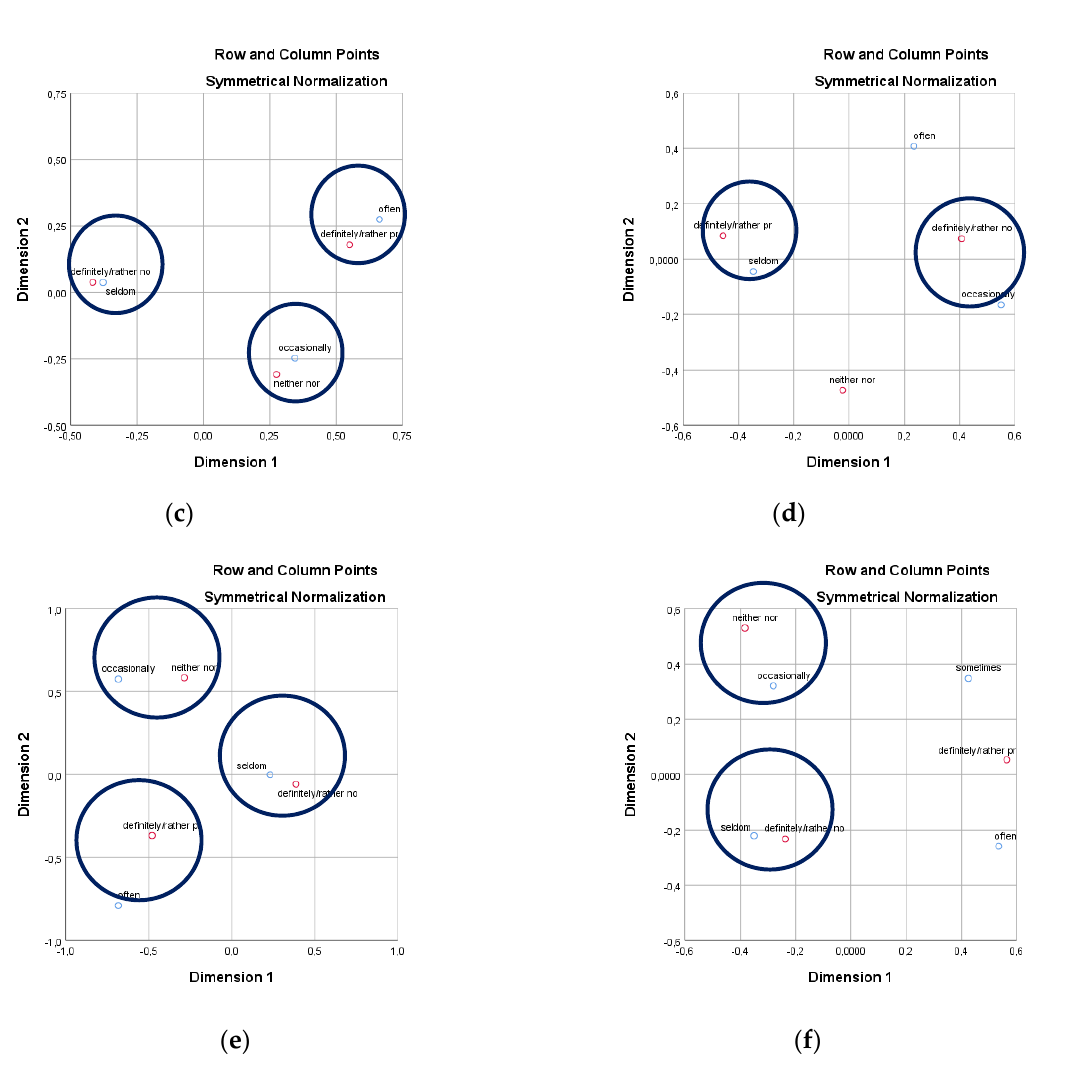
Figure 5. Correspondence maps II: ( a ) there is an association between the frequency of work visits per week and the consumer’s preference for online shopping during the COVID-19 pandemic; ( b ) there is an association between the frequency of shopping per week and the consumer’s preference for shopping in the hypermarket during the COVID-19 pandemic; ( c ) there is an association between the frequency of shopping per week and the consumer’s preference for shopping in the supermarket during the COVID-19 pandemic; ( d ) there is an association between the frequency of shopping per week and the consumer’s preference for shopping through the delivery service during the COVID-19 pandemic; ( e ) there is an association between the frequency of family visits per week and the consumer’s preference for shopping in the supermarket during the COVID-19 pandemic; ( f ) there is an association between the frequency of walking in nature per week and the consumer’s preference for shopping in the local shop during the COVID-19 pandemic.